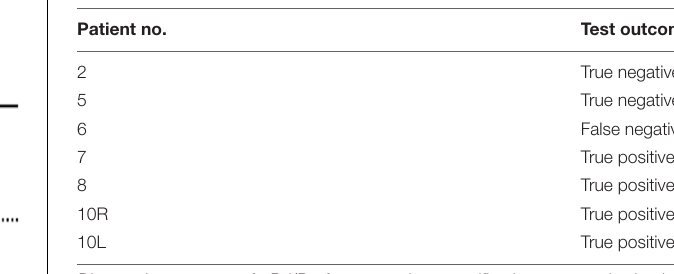
TABLE 4 | Diagnostic accuracy of